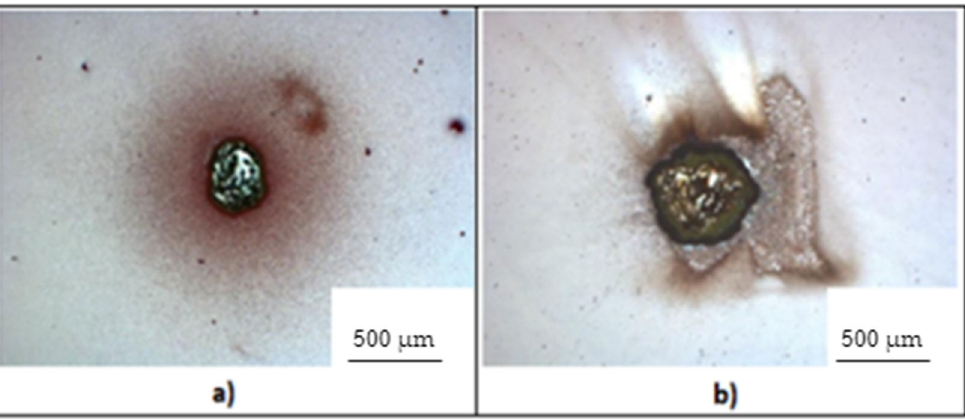
Figure 9. Open fire effect of electric discharge (( a ): sample 10, ( b ): sample 12). The diameter of the crater points to several facts. The force exerted by a lightning strike is significantly influenced by the top coat and primer. Depending on their